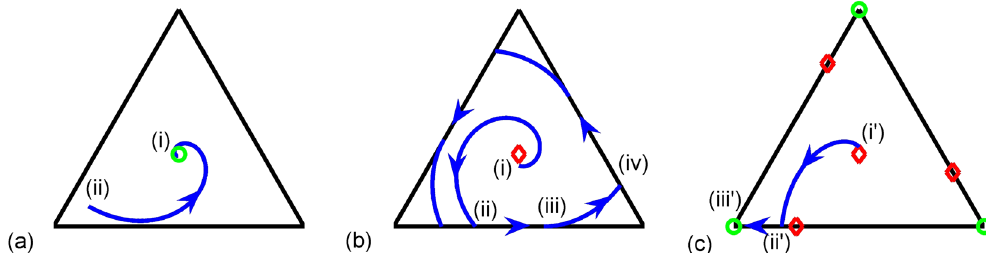
Figure 3. Trajectory of the mean state in the phase-space. Circles (green) represent stable equilibrium points. Diamonds (red) represent unstable equilibrium points. ( a ) Amorphous-state - points (i) and (ii) are starting and finishing points respectively. ( b ) wave-state - (i) is the starting point, (ii) is where the second node empties, (iii) is where the population in the second node begins to repopulate and (iv) is where third node empties. ( c ) collapsed-state - (i ′ ) is the starting point, (ii ′ ) is where the second node empties and (iii ′ ) is where all particles are at the third